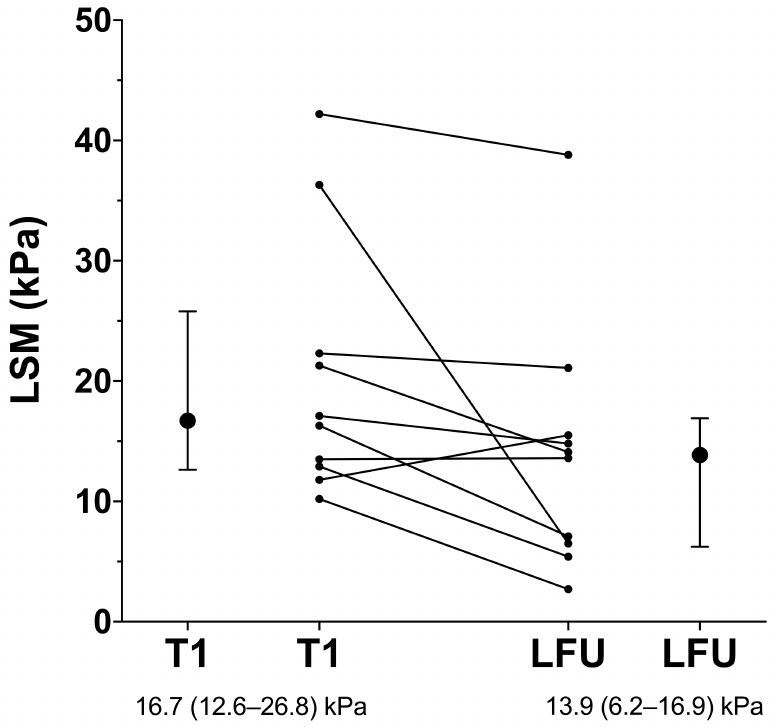
Figure 4. Changes in liver stiffness over time (presented as individual paired values and median and IQR) in patients undergoing an additional liver stiffness measurement during long-term follow-up (LFU). Only one patient showed an increase; the patient was diagnosed with HCC soon after. Abbrevi- ations: T1 = first measurement LSM = liver stiffness measurement; HCC = hepatocellular